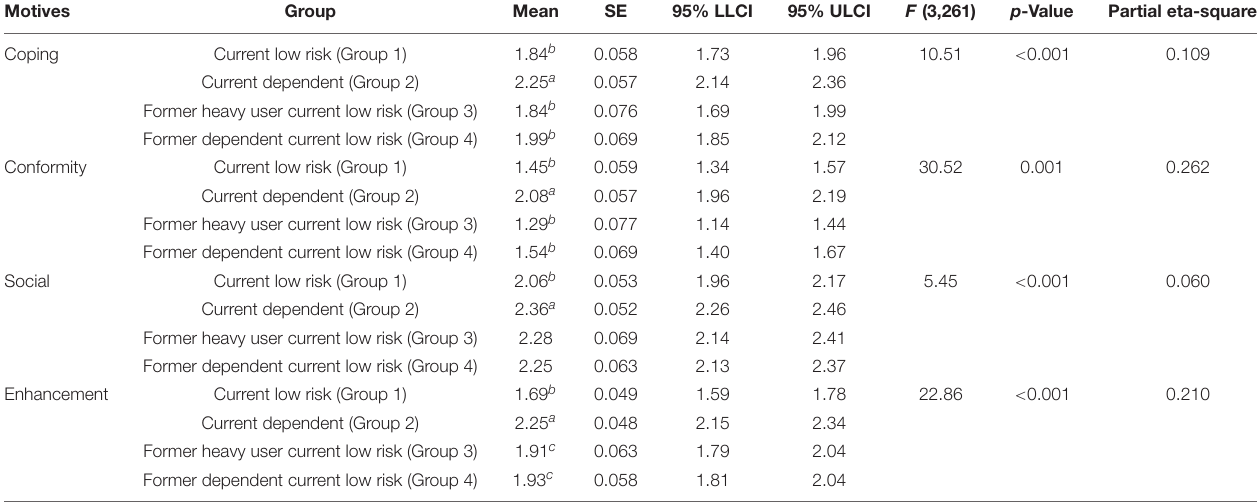
TABLE 4 | Drinking motives (four-factorial)—group comparison. Motives Group Mean SE 95% LLCI Partial eta-squared